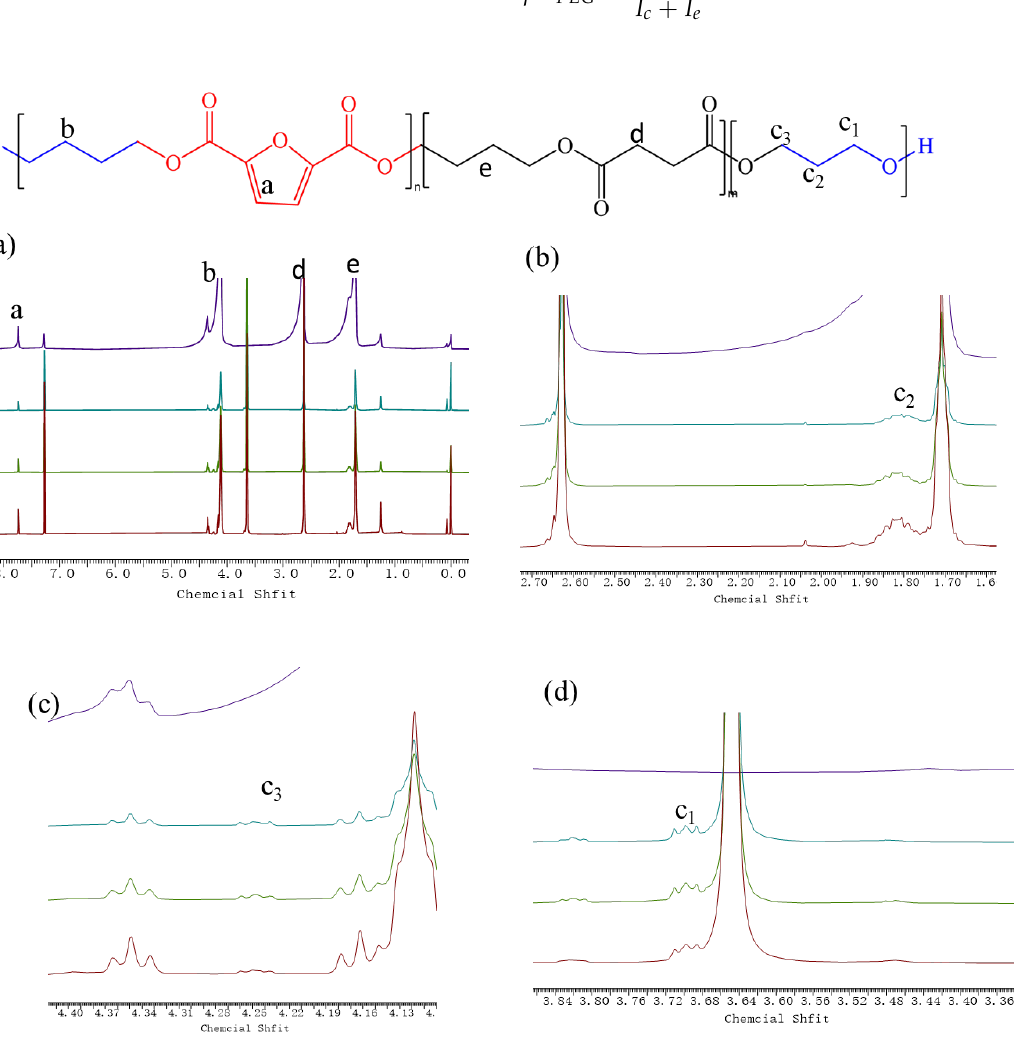
Figure 2. ( a ) 1 H-NMR of the copolyesters and scheme 1. Chemical structures of PBSF-PEG ( b – d ) 1 H-NMR of the copolyesters PEG.